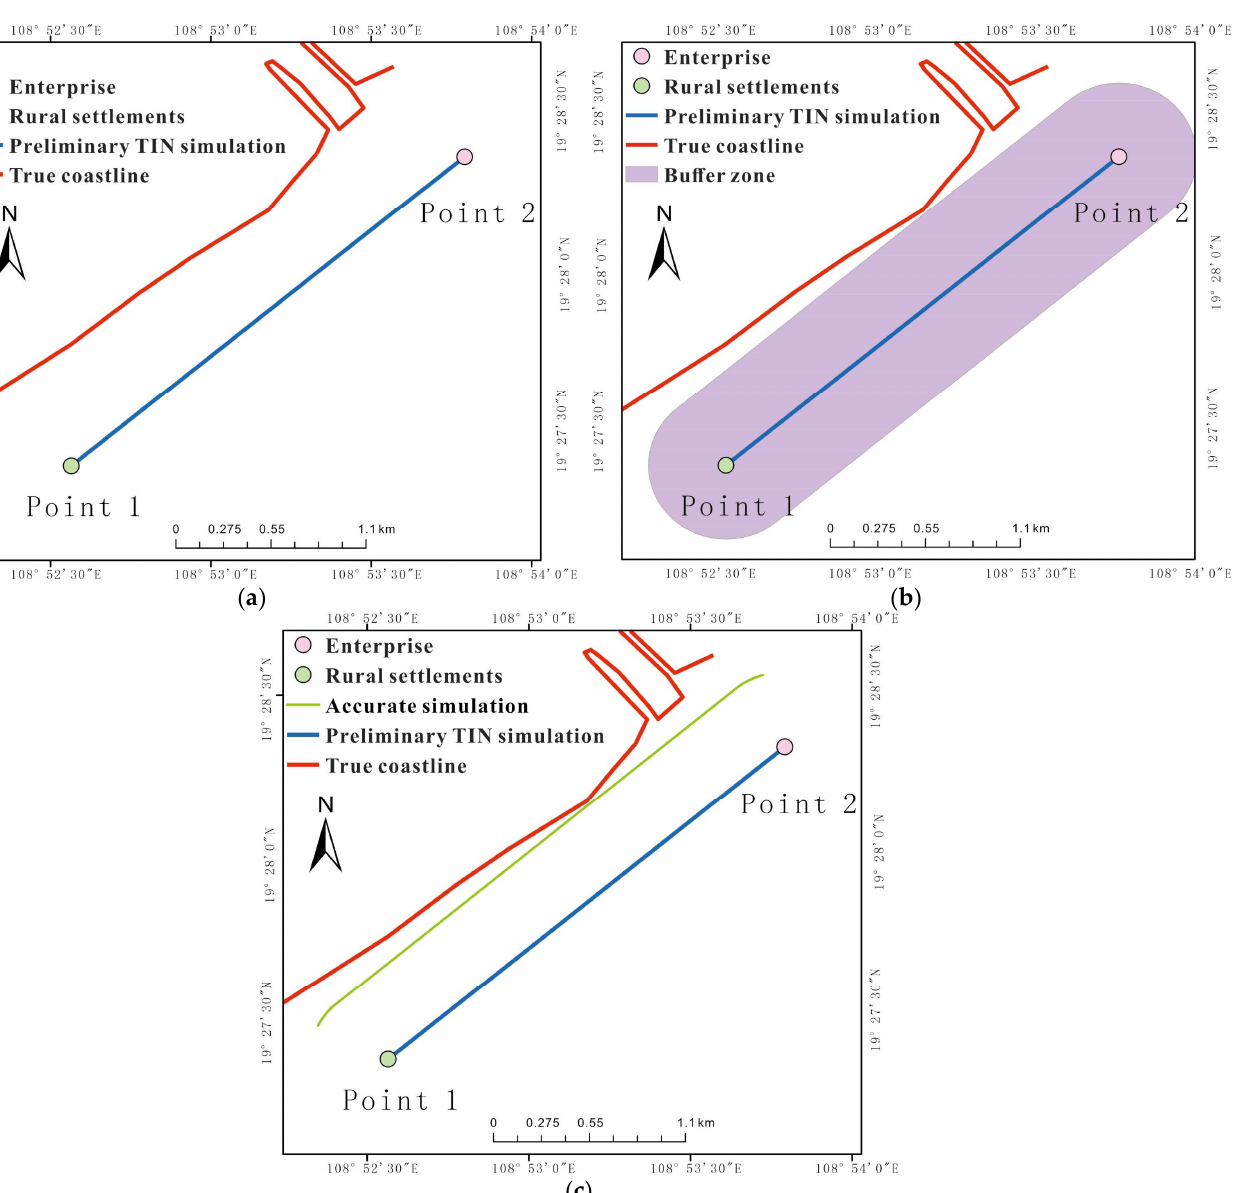
Figure 7. ( a ) Preliminary TIN simulation. ( b ) Production of buffer zone. ( c ) Result of the section-by-section analysis. Section-by-section analysis: there is a large error in the initial TIN simulation results, so the buffer analysis of each line segment makes it closer to the real coastline.